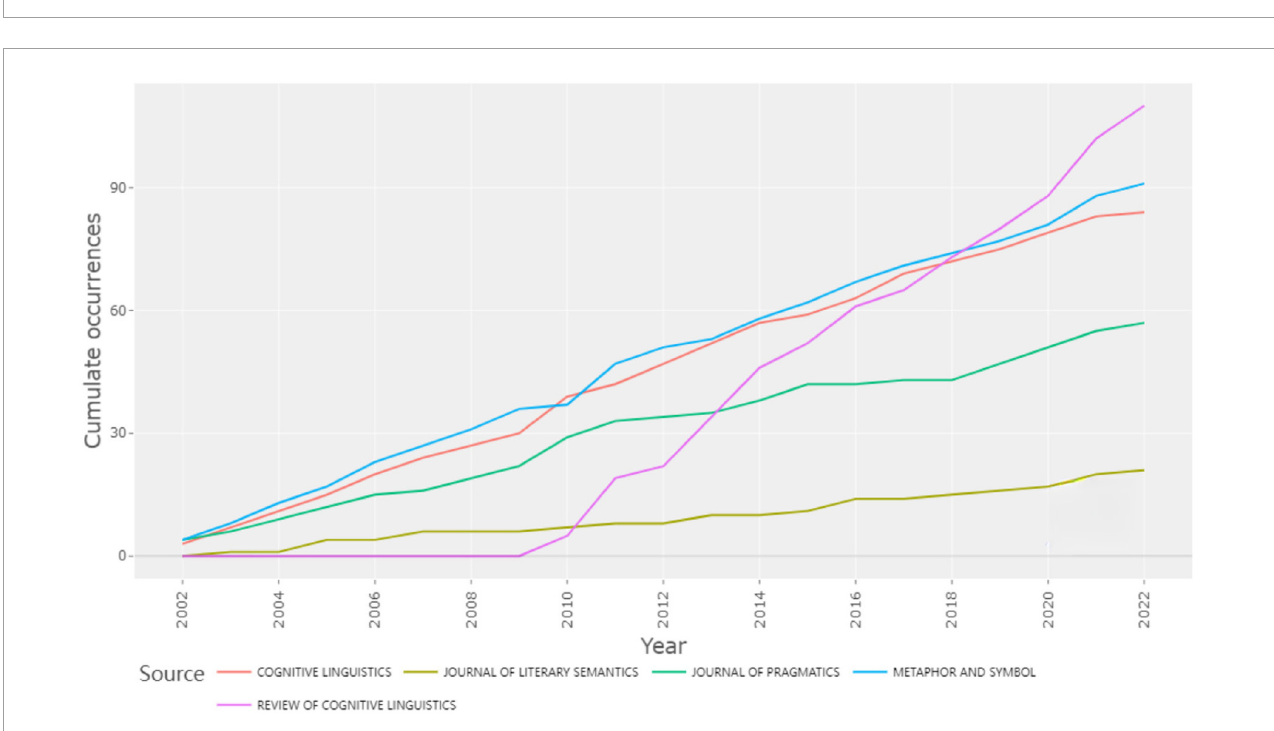
FIGURE3 Most global cited documents.